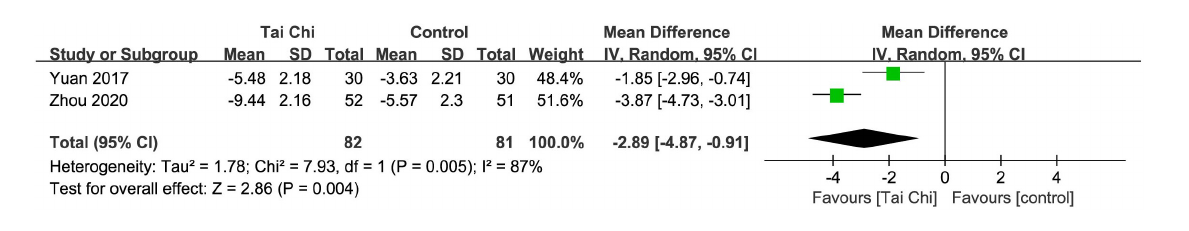
FIGURE7 Meta-analysis of HAMD in the Tai Chi group vs. the control group. CI, confidence interval; IV, inverse variance; SD, standard deviation.